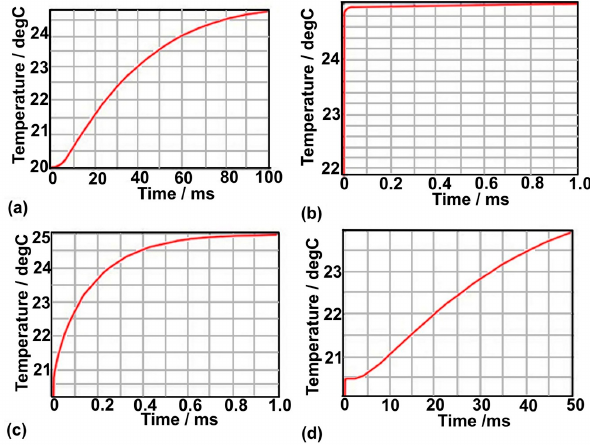
Figure 5. Calculated time variation of the average temperature at the top surface: ( a ) the mean temperature of the top surface of the polymer without fiber; ( b ) the mean temperature of the top surface of the fiber; ( c ) the mean temperature of the composite PM+fiber with zero thermal resistance at the interface PM/fiber; ( d ) the same as (c), but with infinite thermal resistance at the interface.